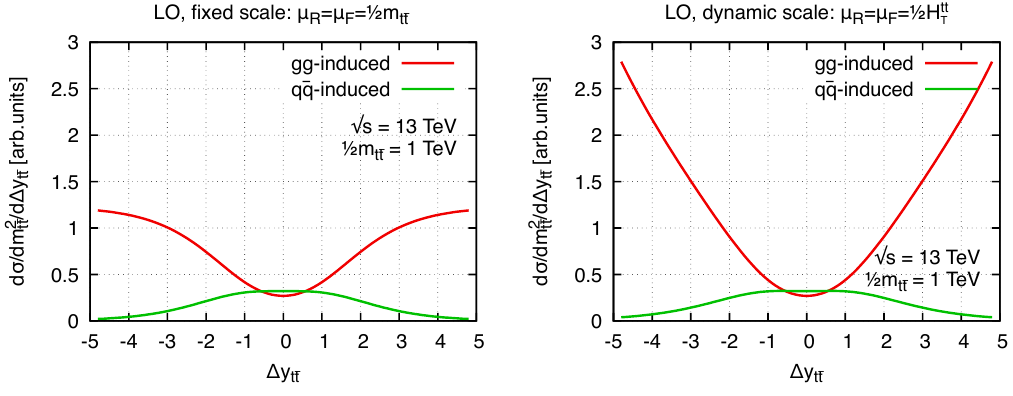
distribution at fixed large m , as given in Figure 10 . Asymptotic leading-order forms for the ∆ y t ¯ t t ¯ t √ eq. (A.1), applied to the case of = 2 TeV . The left-hand plot uses s = 13 TeV pp collisions and m t ¯ t fixed renormalisation and factorisation scales, which is physically inappropriate but illustrates the key analytical features of the structure of eq. (A.1). The right-hand plot uses a physically motivated scale choice, of the order of the momentum transfers involved in the